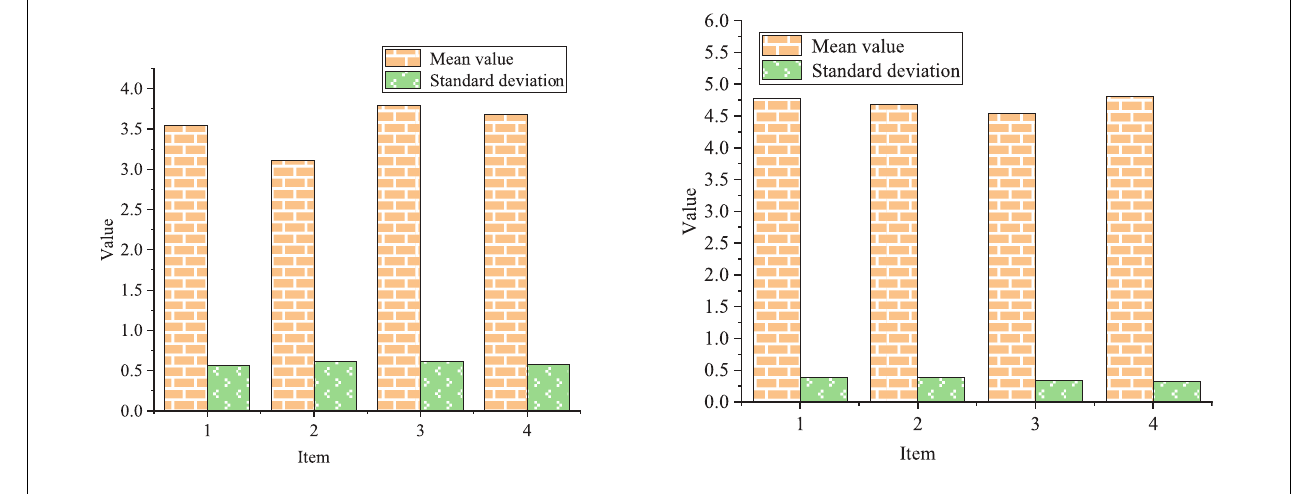
FIGURE 9 | Statistical results of evaluation